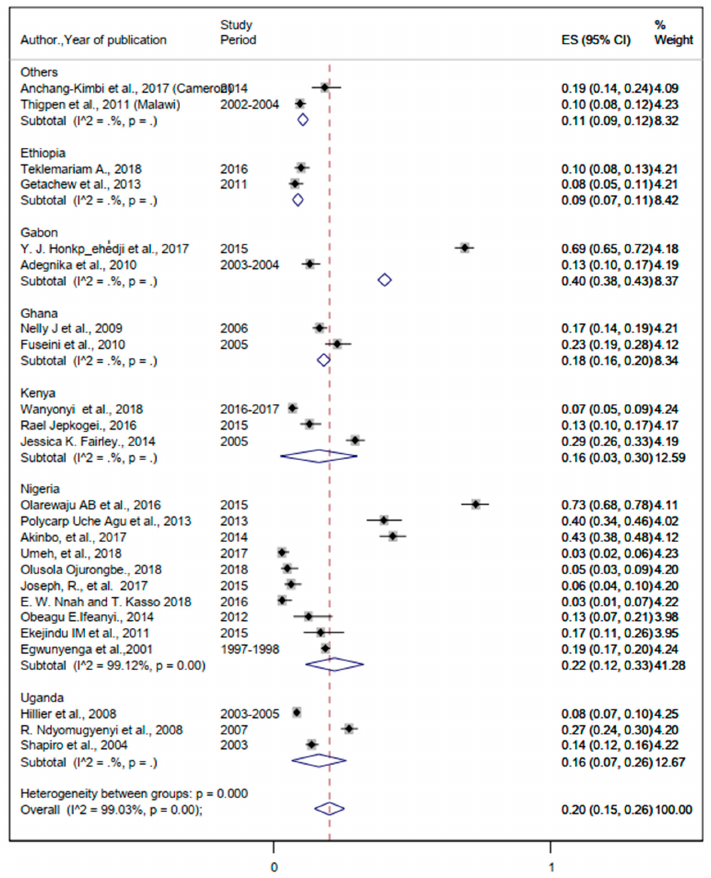
Figure 8. The overall pooled estimate and country-specific prevalence of malaria and helminthic co-infection among pregnant women in sub-Saharan